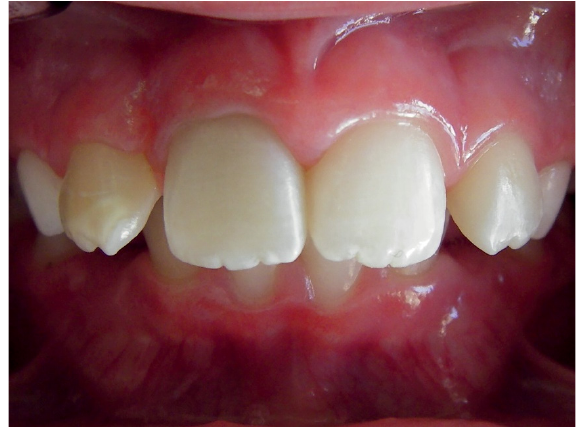
Figure 5. Gray discoloration of the crown of tooth 11 after subluxation. This is a rare finding in teeth with